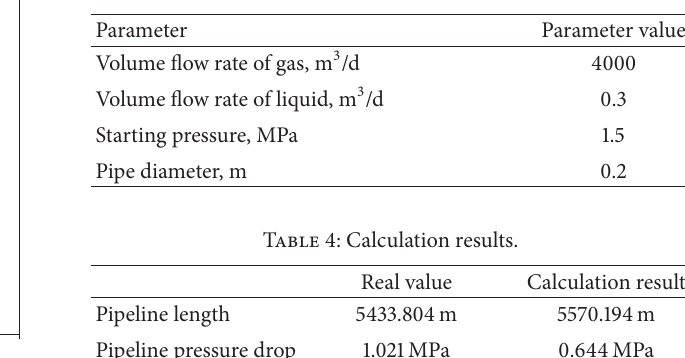
Table 3: Parameter of pipeline simulation.